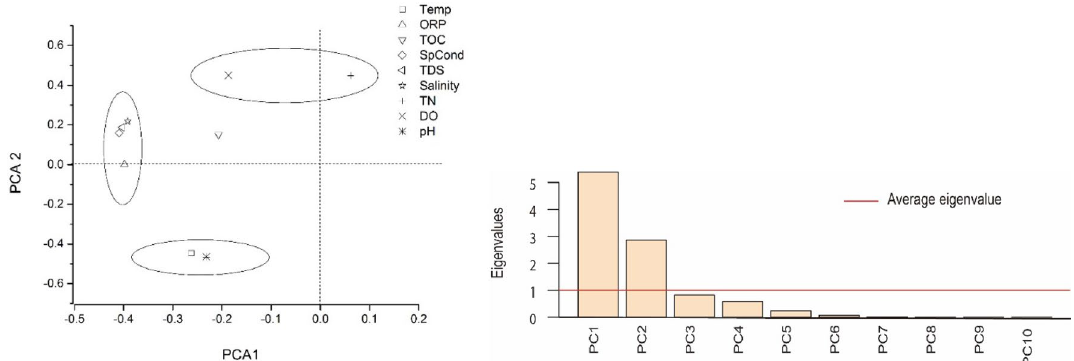
Figure 6. PCA of various environmental factors in the surface-flow constructed wetlands.